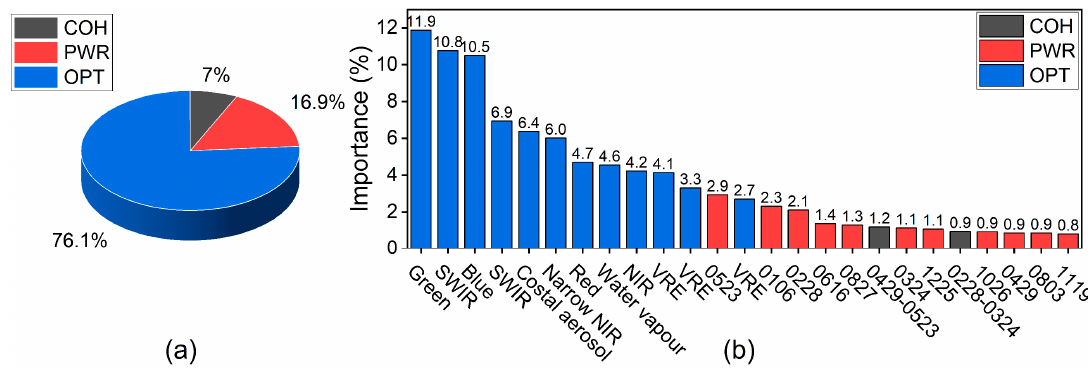
Figure 14. The importance of different bands in OPT + PWR + COH datasets to classification results of RF classifier. ( a ) The importance of three remote sensing data types (COH, PWR, OPT) to the classification results of RF classifier. ( b ) The top 25 bands of importance out of 37 bands. VRE represents the band of vegetation red edge, NIR shows the band of near infrared, and SWIR indicates the band of shortwave infrared.